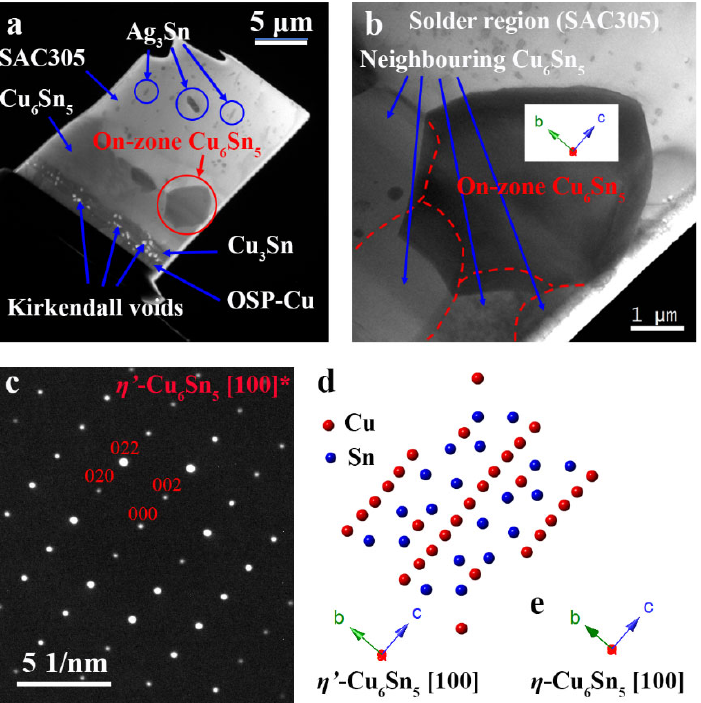
Figure 2. ( a ) Low magnification on-zone bright-field (BF) plasmon filtered TEM image of the lamellar before the heating experiment. ( b ) Image of the on-zone Cu 6 Sn 5 on top of four other Cu 6 Sn 5 grains, and ( c ) the SAED pattern of the on-zone grain ( d ) a schematic of the crystal structure showing the crystal orientation, and ( e ) the equivalent orientation in a η -Cu 6 Sn 5 crystal to produce the diffraction pattern indexed in ( c ).